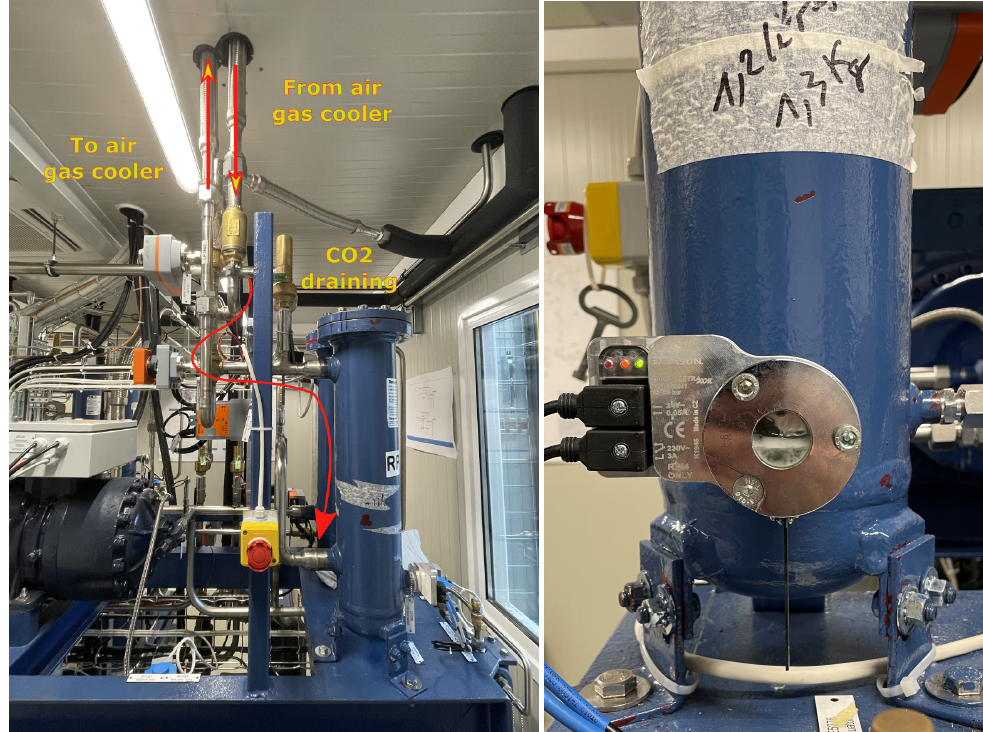
Figure 11. ( left ) Path followed by CO 2 being draining into separators. ( right ) Visualisation through oil level sensor sight glass of CO 2 condensing inside oil